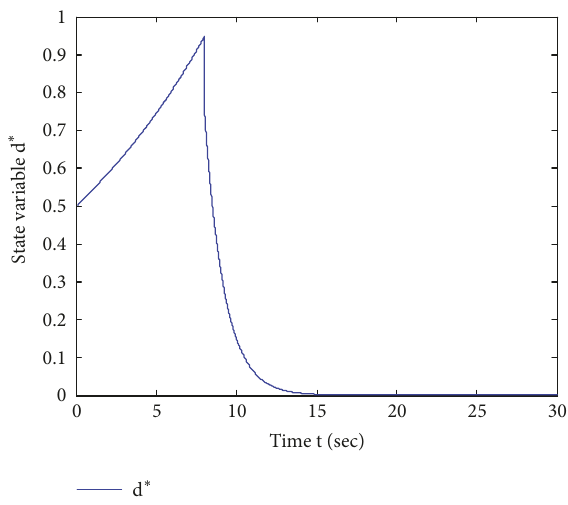
Figure 10: The stability of distance error 𝑑 ∗ with respect of time.